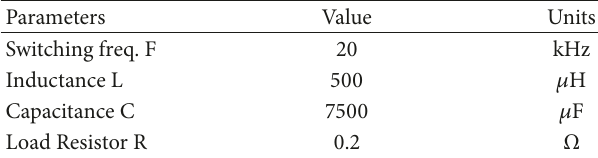
Table 5: Boost converter